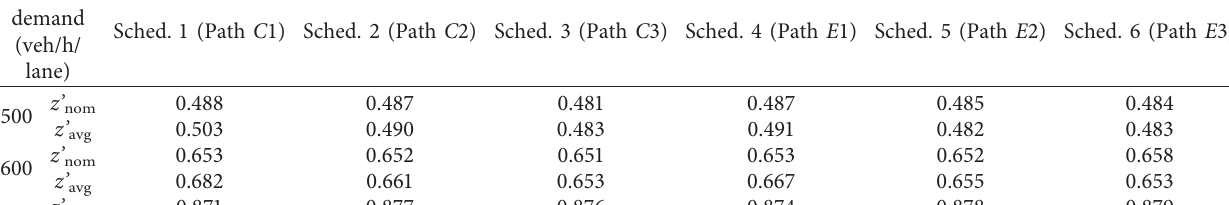
Table 1: Travelling efficiency performance of different nominal left-turn paths.